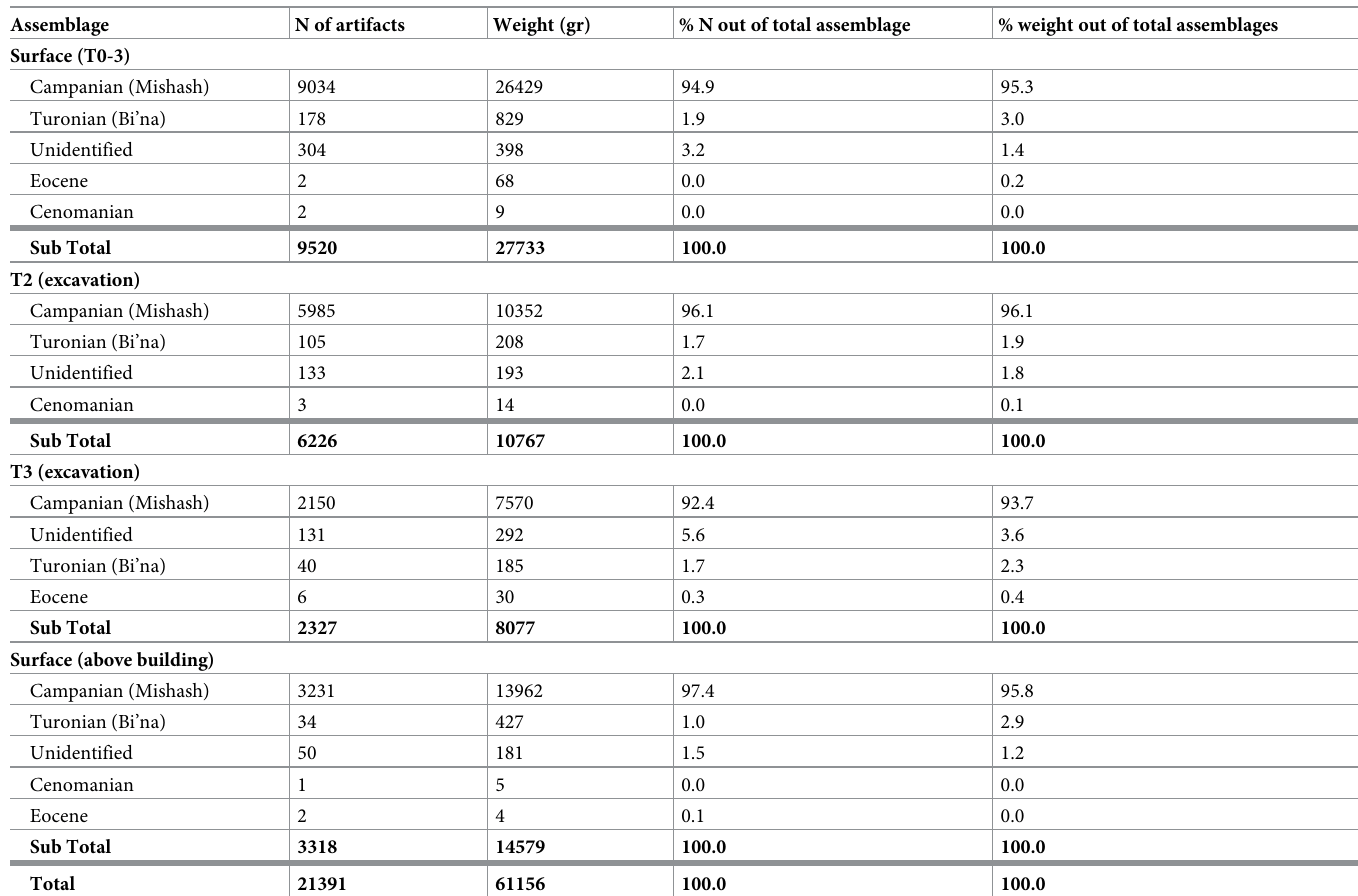
Table 3. The lithic assemblages analyzed by geologic origins and weight.